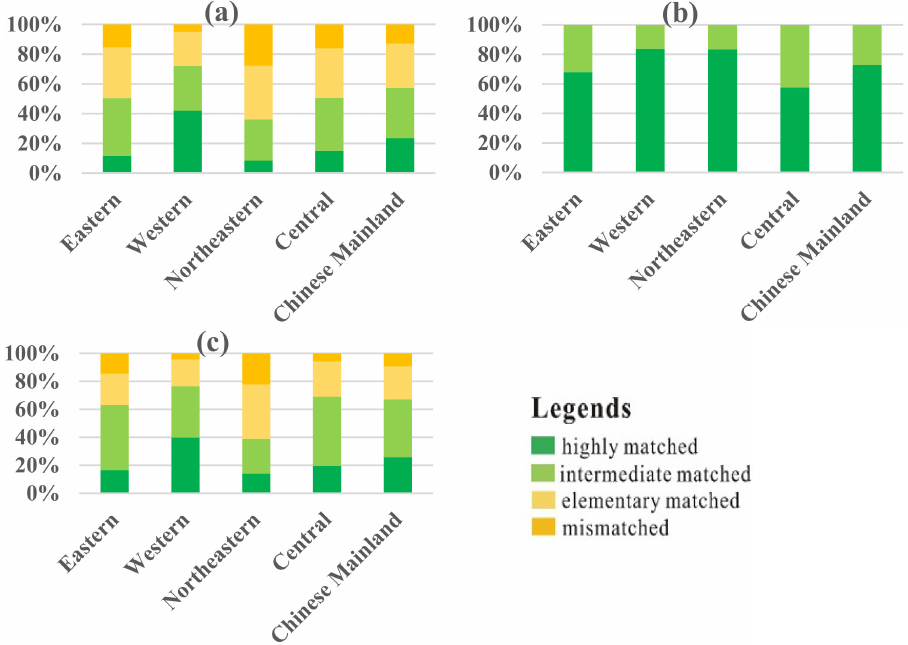
Figure 5. Proportion of units with different matching levels in ( a ) GD-ED, ( b ) PD-GD, and ( c ) ED-PD in Chinese Mainland during the investigation